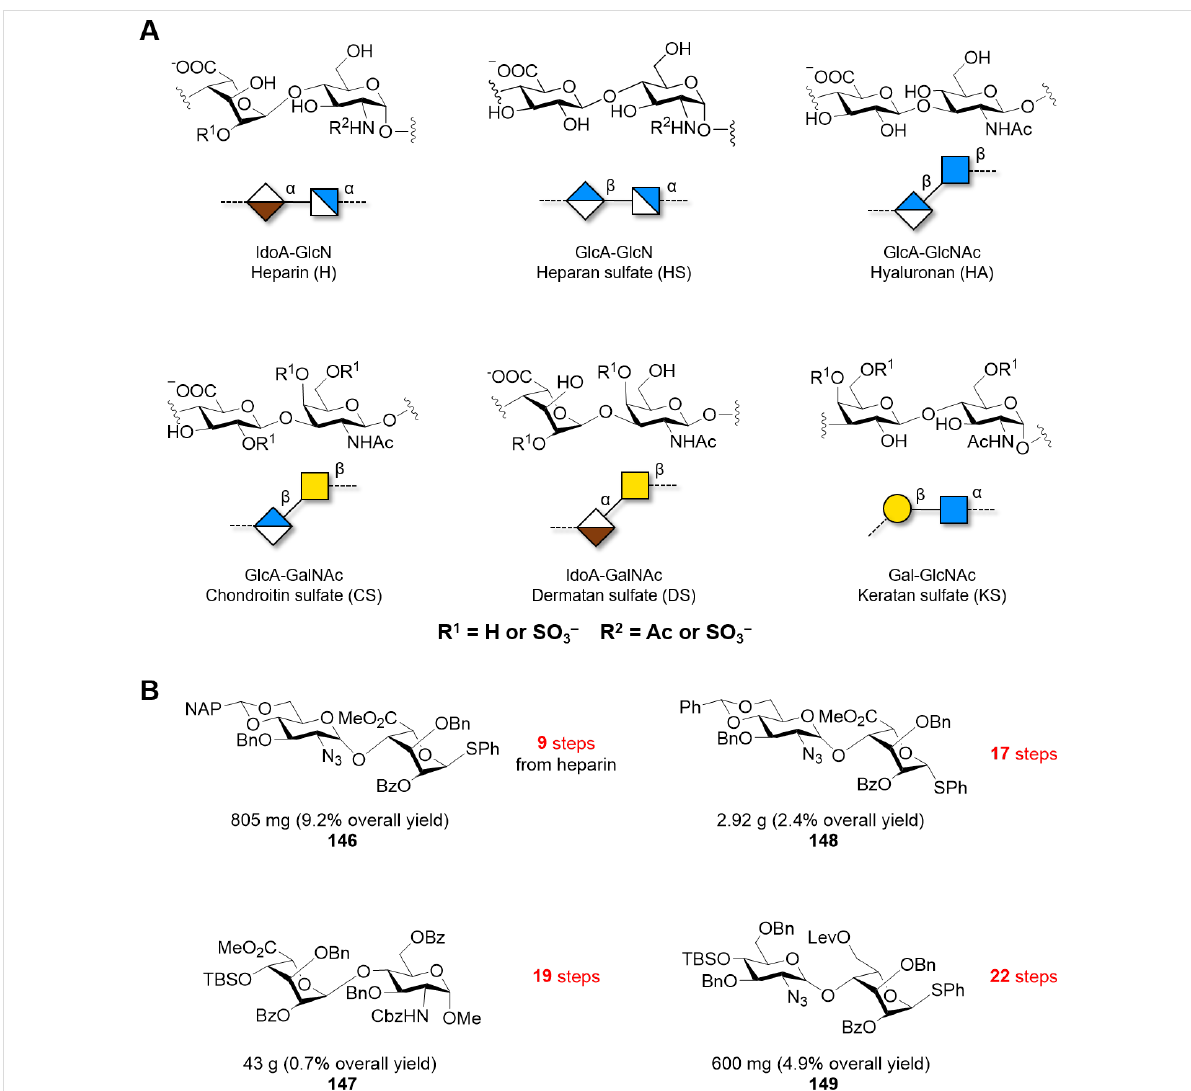
Figure 16: A) Chemical structure and SNFG of the representative disaccharide units forming the GAG backbones, and B) representative examples of synthetic disaccharides used for the preparation of HS